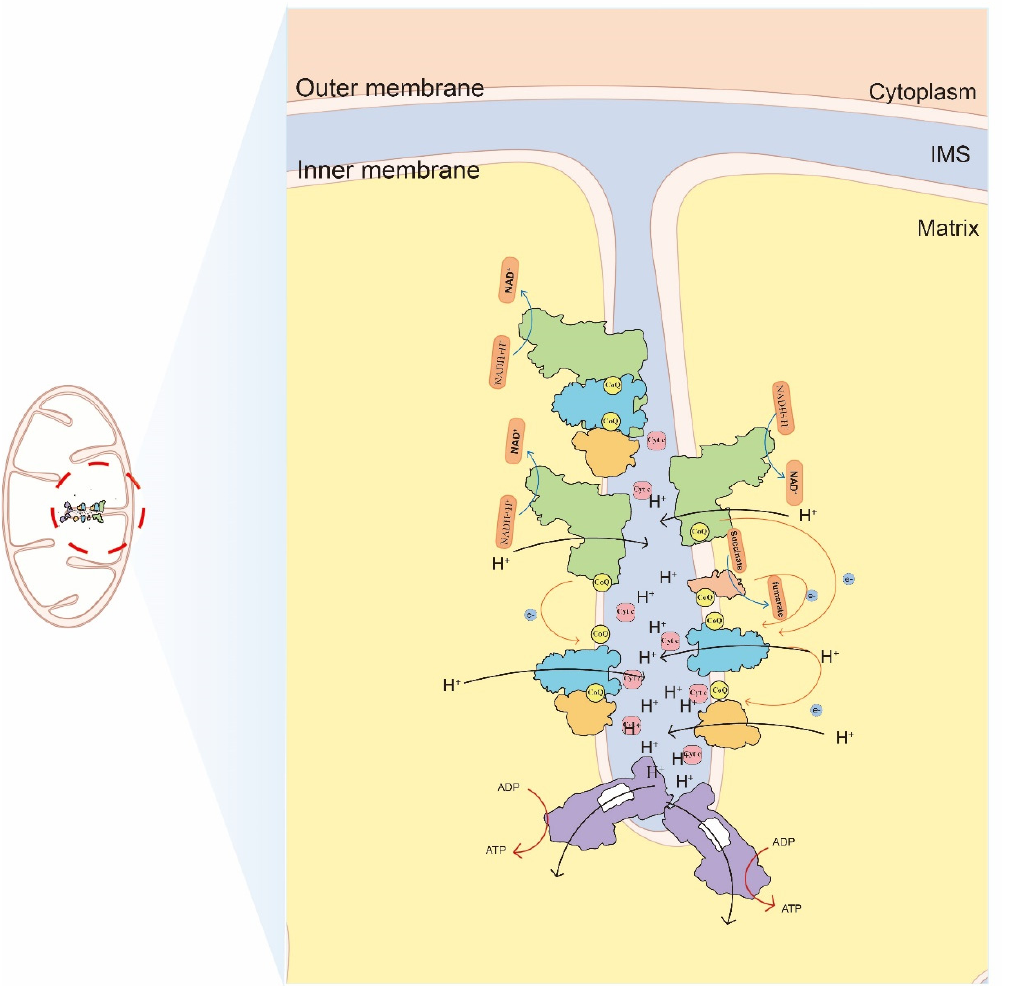
Figure 1. Mitochondrial cristae and the oxidative phosphorylation located on cristae. The free complexes and SCs transport electron to others though two mobile electron carriers and generate ATP. The position of cytoplasm, matrix, intermembrane space (IMS), cristae and inner membrane are indicated. The complexes are distinguished by different colors: CI: green, CII: pink, CIII dimer: blue, CIV: orange, CV: purple.